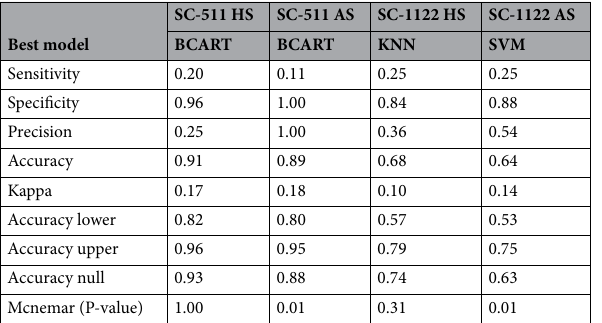
Table 3. Modeling performance from the best machine learning algorithm for seedling data for high (HS) and average (AS) disease scores for scald disease in barley set. BCART Bagged Carts, KNN K-nearest neighbors, SVM support vector